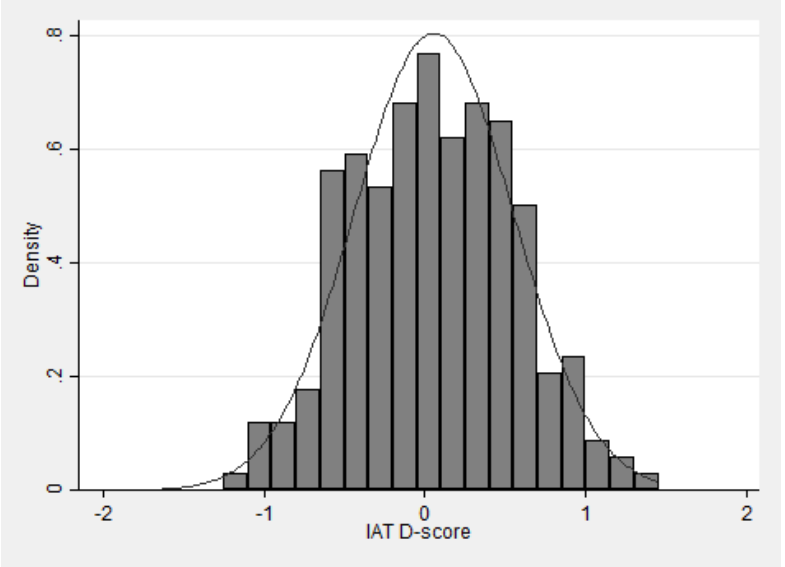
Figure 2. Distribution of IAT